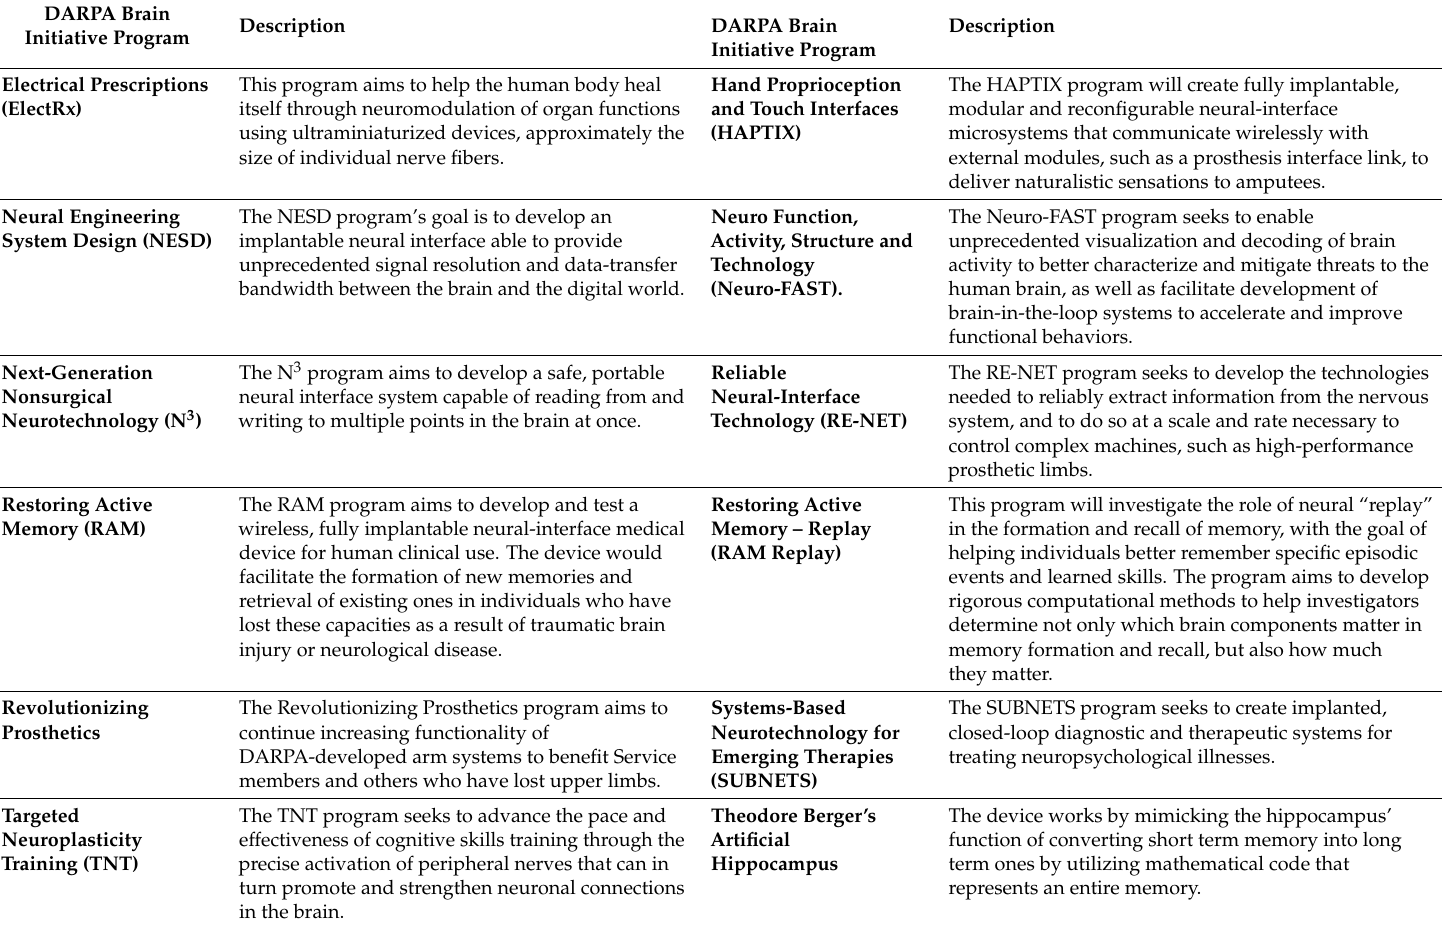
Table 2. Examples of brain enhancement programs (DARPA is gratefully acknowledged for use of the